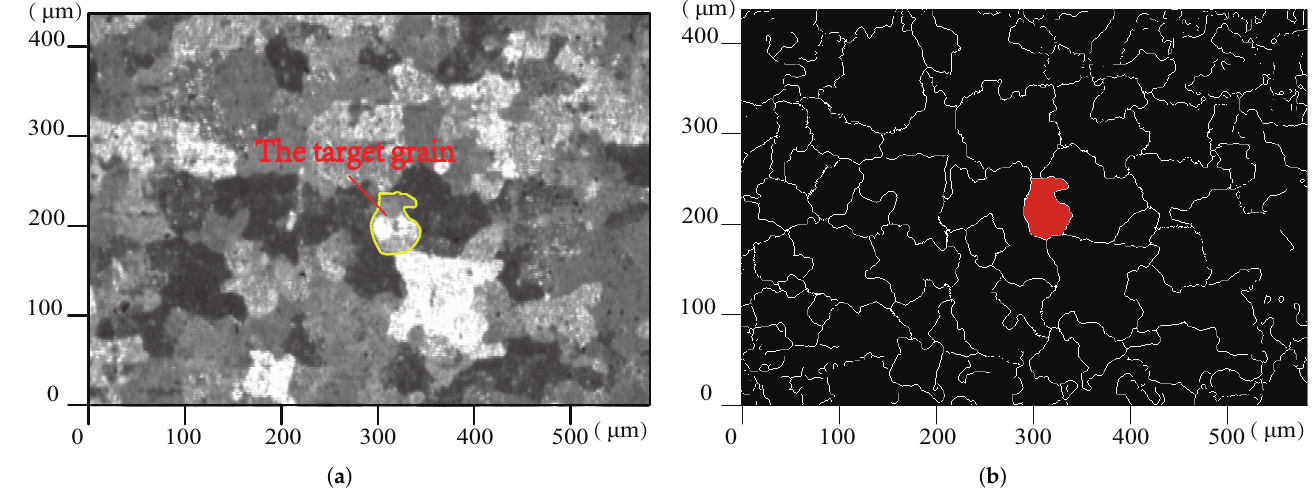
Figure 8. ( a ) The target grain of the grain diagram when F = 200 N; ( b ) the corresponding boundary